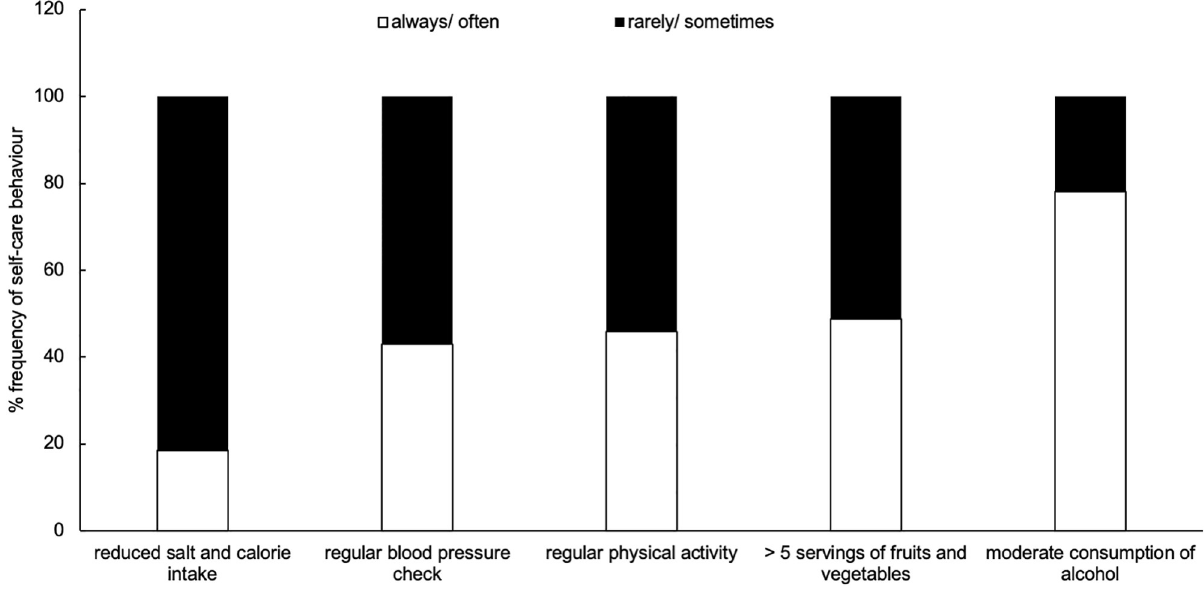
Fig 2. Percentage frequency of self-care behaviour among the community in Selangor and Kuala Lumpur (N = 200).